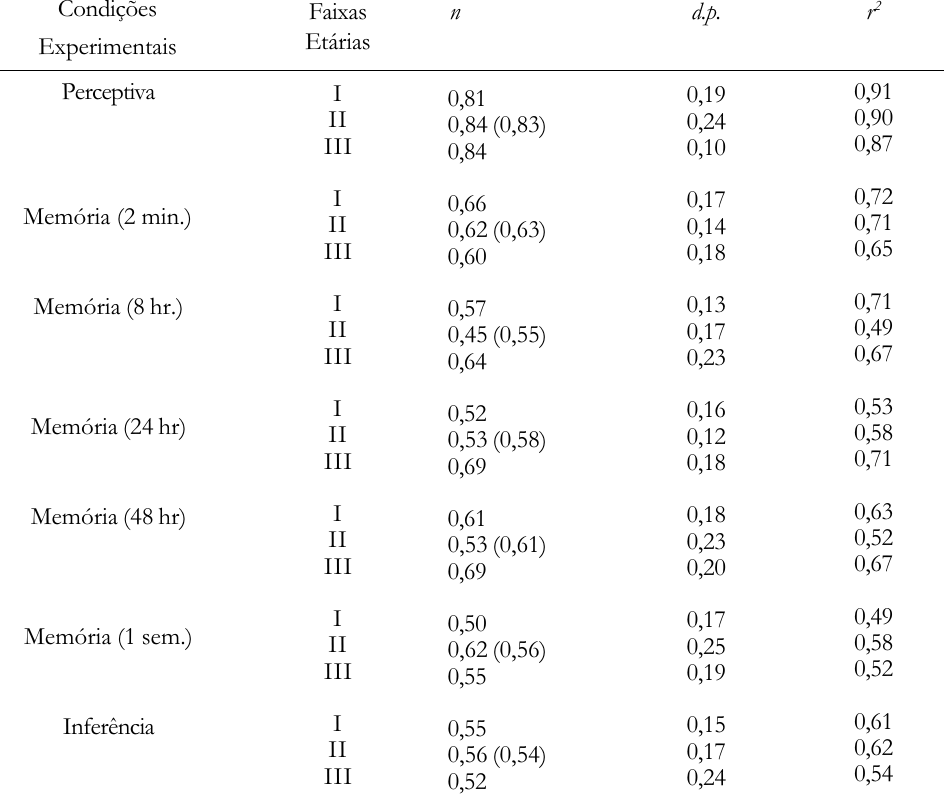
Tabela 1. MØdias ( n ) e Desvios-Padrªo ( dp ) dos Expoentes da Fun(cid:231)ªo-PotŒncia e MØdias dos Coeficientes de Determina(cid:231)ªo ( r 2 ) derivados das Condi(cid:231)ıes Perceptiva, Mem(cid:243)ria e